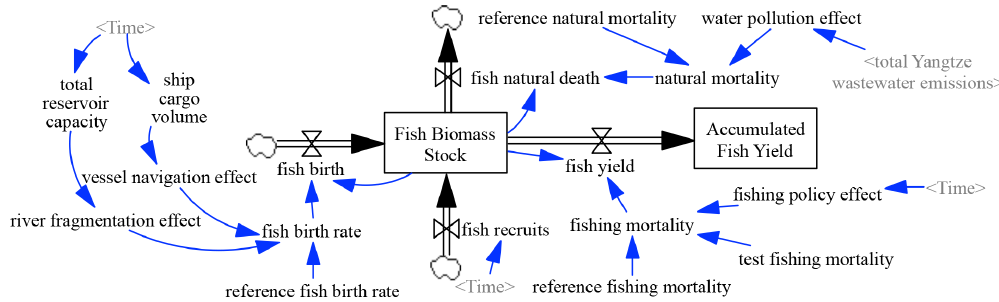
Figure 16. Stock and flow of the fish